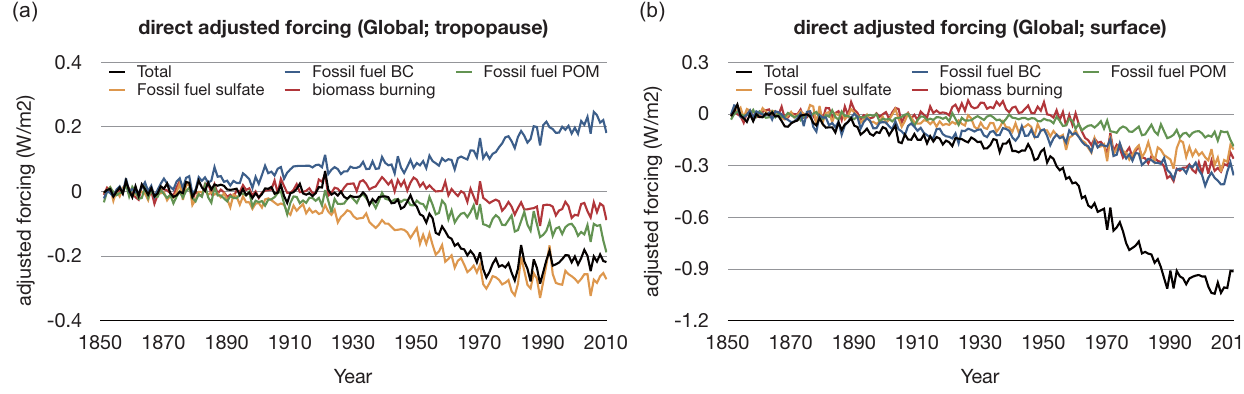
Fig. 10. Global distributions of adjusted forcing due to the aerosol direct effect at the surface in (a) 2000 (averaged over the period 1998–2002) and (b) – (e) 2050 (averaged over the period 2048–2052) for the four RCPs relative to the preindustrial experiment simulated by SPRINTARS.